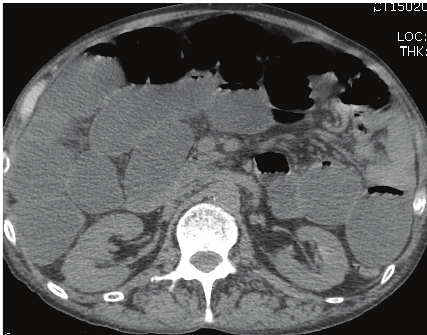
Figure 1: CT scan of the abdomen showing small bowel dilatation.